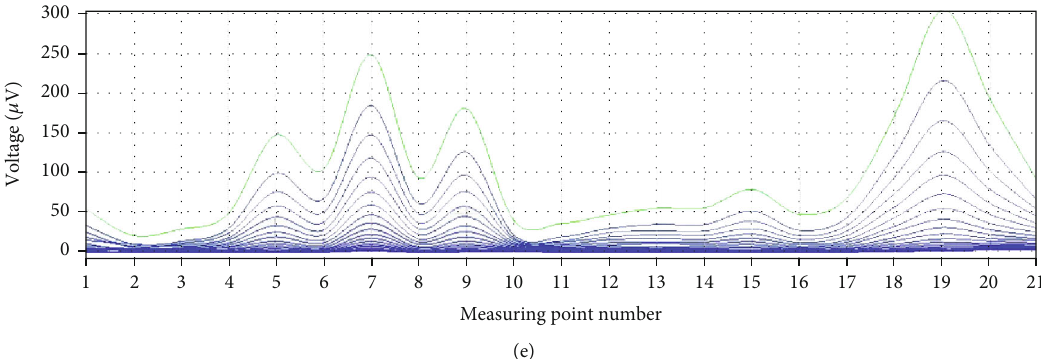
Figure 5: The change rule of resolvable voltage on di ff erent survey lines: (a) survey line 1; (b) survey line 2; (c) survey line 3; (d) survey line 4; (e) survey line